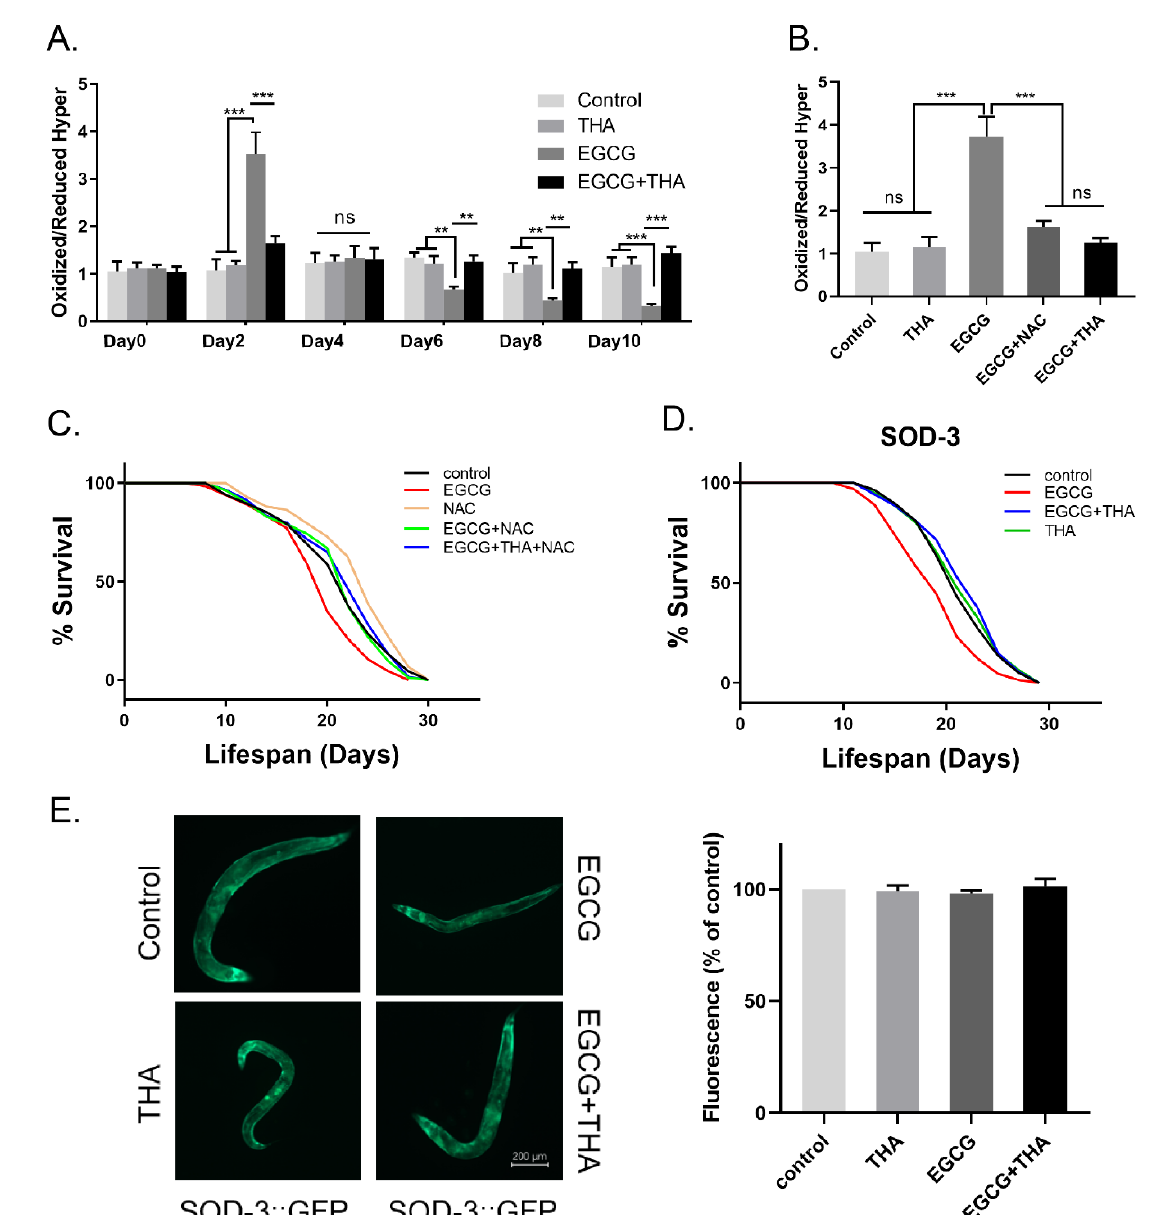
Figure 4. Changes in Reactive Oxygen Species (ROS) levels induced by high doses of EGCG were eliminated by theanine. ( A ) Relative formation of ROS throughout the life cycle after exposure to EGCG (1000 µ M), N-acetylcysteine (NAC) (5 mM), and theanine (200 µ M) in the JV1 worms. ( B ) Relative formation of ROS after 72 h of exposure to EGCG, NAC, and theanine in the JV1 worms. ( C ) Survival curves with EGCG, NAC, and theanine. ( D ) SOD-3 mutant strains were treated with EGCG and theanine starting from adulthood (day 0). Survival was recorded every two days, until all of the worms died ( n = 90–105 worms/treatment). ( E ) SOD-3 expression after 72 h exposure to EGCG and theanine, representative images are shown (×200 magnification). All error bars represent SEM, and differences were considered significant at ** p < 0.01 and *** p < 0.001, ns—no significance.